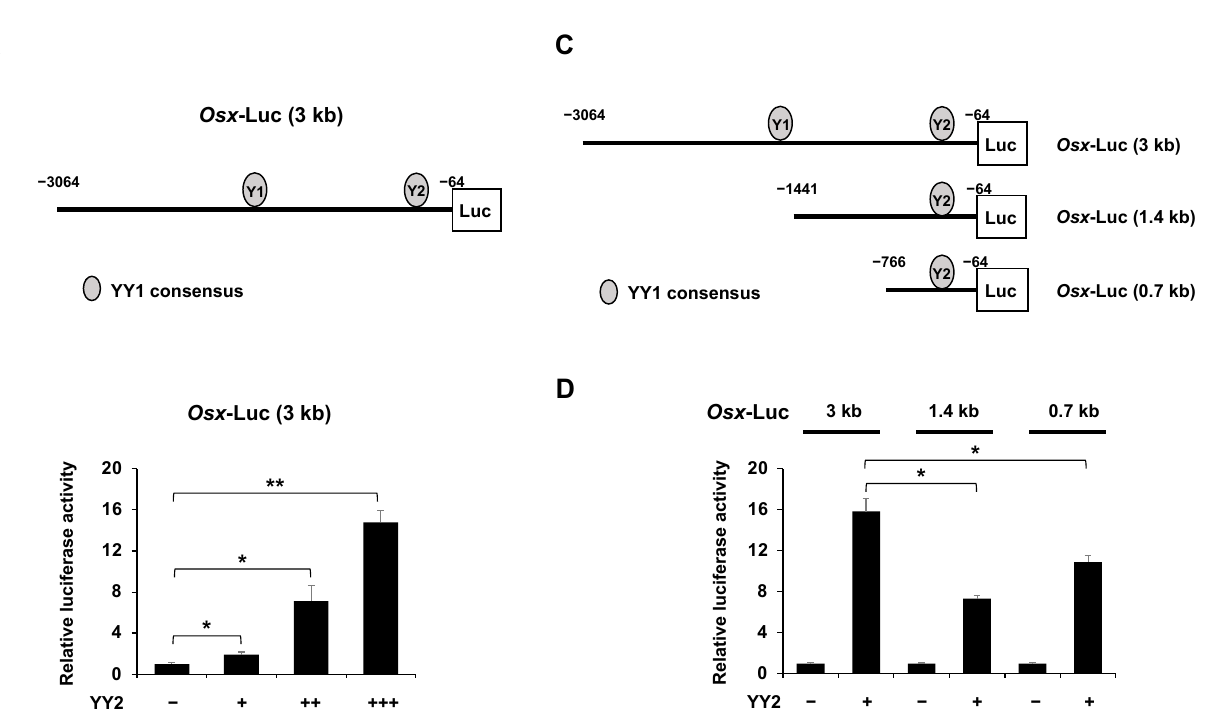
Figure 5. YY2 activates the Osx promoter activity. ( A ) Schematic diagram of pGL3 vector constructed human Osx promoter (from − 3064 to − 64). HEK 293cells were transfected with the indicated reporter gene { Osx -Luc (3 kb), Osx -Luc (1.4 kb), or Osx -Luc (0.7 kb)} (0.3 µ g) and β -gal (0.05 µ g) and YY2 expression plasmid. After 48 h, luciferase activities were measured. ( B ) The effect of YY2 on Osx promoter activity. Overexpression of YY2 significantly enhanced Osx promoter activity in a dose-dependent manner. ( C ) Schematic diagram of pGL3 vector constructed with the indicated range of Osx promoter region (3 kb, 1.4 kb, and 0.7 kb size). ( D ) The effect of YY2 on Osx promoter activity in the different Osx promoter (3 kb, 1.4 kb, and 0.7 kb size). YY2-activated Osx promoter activity was significantly attenuated in Osx -Luc (1.4 kb and 0.7 kb) compared to Osx -Luc (3.0 kb). Data are expressed as mean ± SEM of at least three experiments. * p < 0.05 and ** p < 0.01.